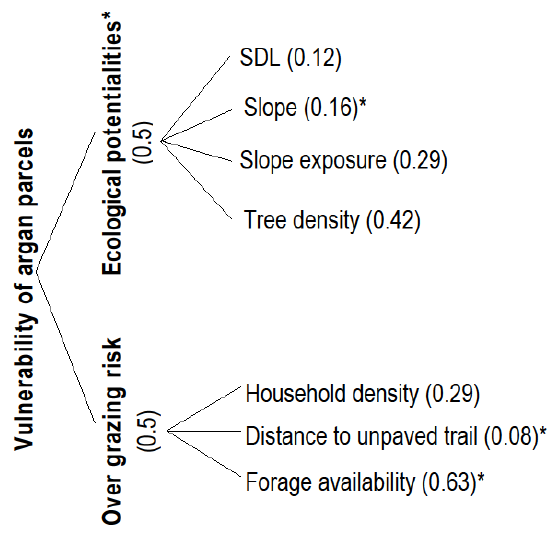
Figure 3. Components and weights (between brackets) used to estimate the vulnerability of argan parcels to further degradation. All variables are standardized (between 0 and